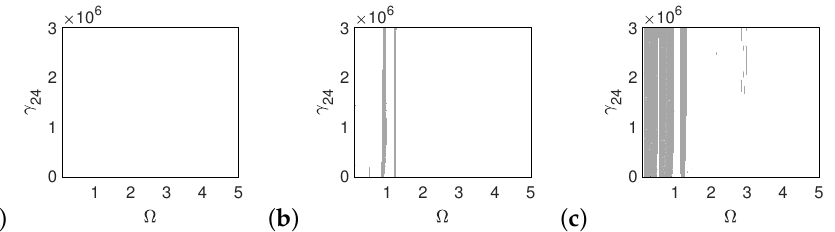
Figure 16. Regions of polyharmonic vibrations of the magnet in case of the pathological ear versus the nonlinear stiffness rate of the coupler ( γ 24 ) and the excitation frequency ( Ω ) under excitations of p ( a ), 5 p ( b ) and 10 p ( c ).